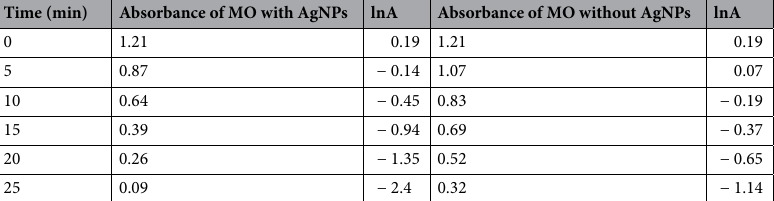
Table 7. Degradation of methyl orange (MO) with and without biosynthesized silver nanoparticles at 460 nm along with lnA calculated from pseudo-first-order